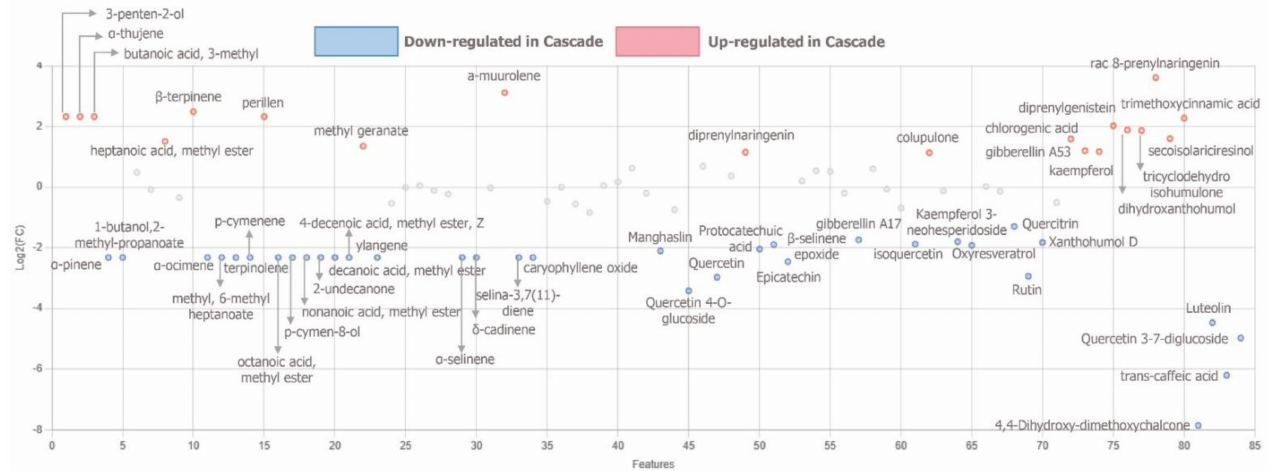
Figure 8. Important features selected by the fold-change analysis with a threshold of 2.5. The red circles represent features above the threshold upregulated in Cascade, and the blue circles represent the metabolites downregulated in Cascade. Metabolites that were not significantly changed are shown by gray dots. In the y -axis are reported values based on log2 scale, so that both upregulated and downregulated features can be plotted in a symmetrical way; in the x -axis are reported the feature values. The metabolites upregulated in Cascade were 19, whereas downregulated in Cascade, there were